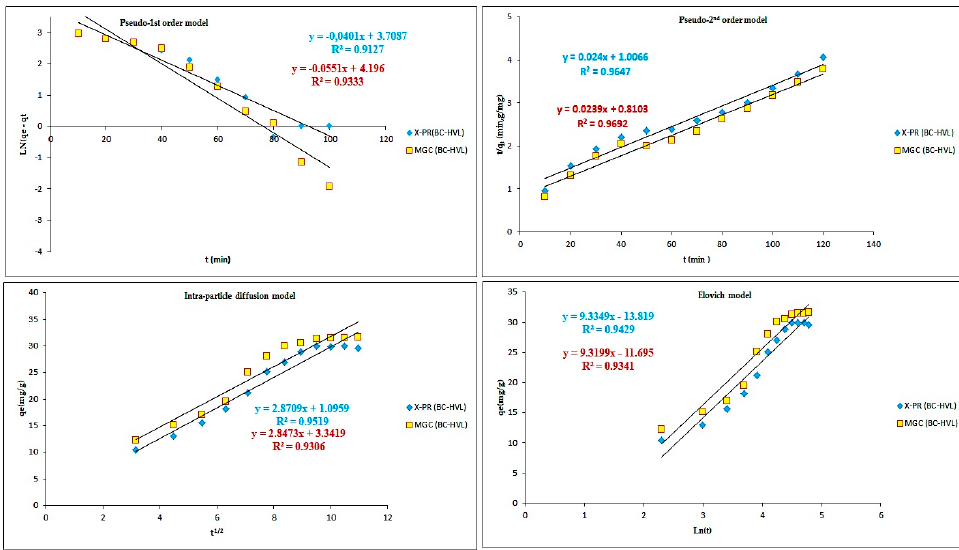
Figure 16. Kinetic models of the adsorption of the dyes X-PR and MGC by BC-HVL (T = 21 ± 1 °C; mad = 50 mg; C 0 = 50 mg·L − 1 ; stirring speed 150 rpm and pH = 7 ± 0.3). Table 1. Adsorption kinetic constants of X-PR and MGC by BS-HVL (T = 21 ± 1 °C; m ad = 50 mg; C 0 = 50 mg L − 1 ; stirring speed 150 rpm and pH = 7 ± 0.3).